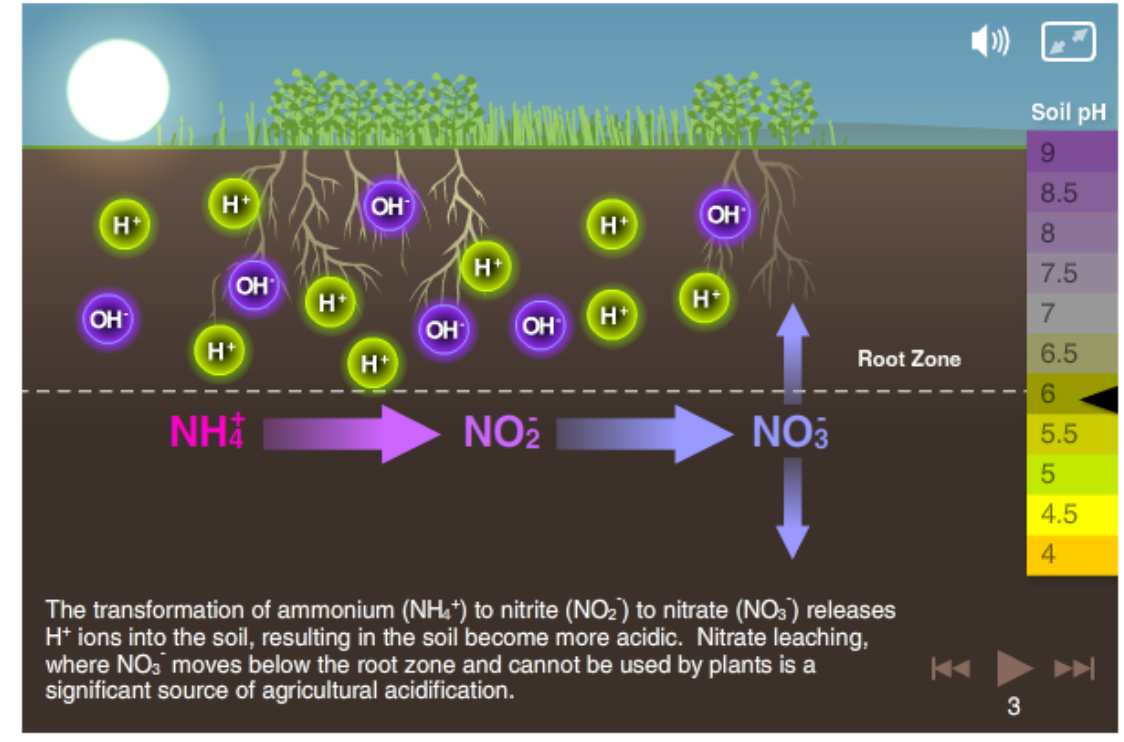
Figure 15. A scene from the soil acidification animation.  State of Victoria, Department of Primary Industries 1997 Reproduced with permission. From: